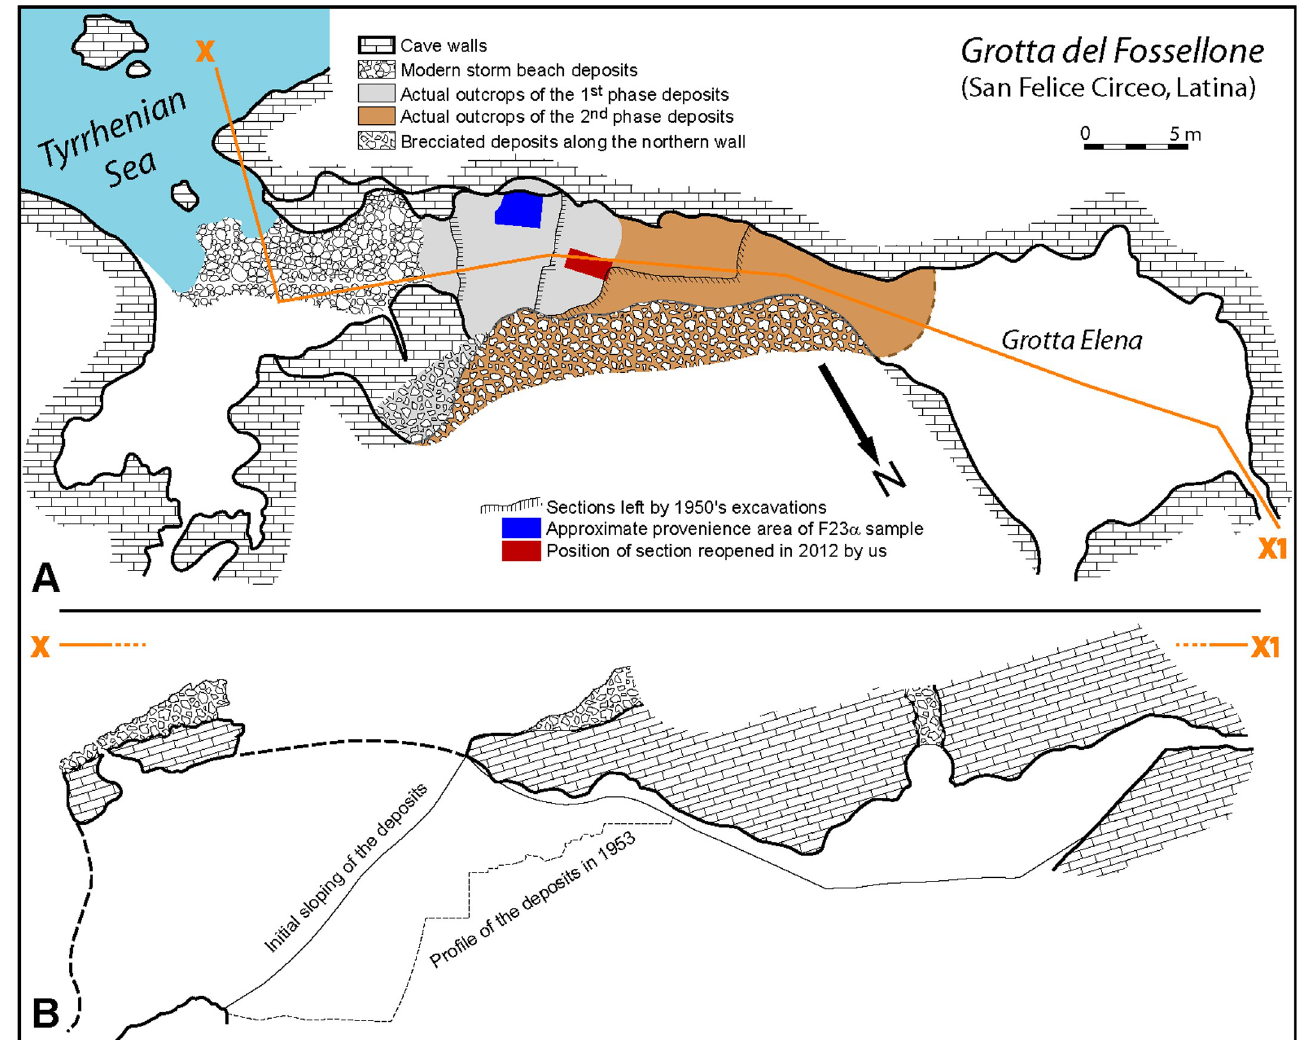
Fig 2. Plan and section of Grotta del Fossellone. ( A) Plan of the cave with location of the 2012 fieldwork, intact remnants of Pleistocene deposits and approximate provenience of F23 α sample from the 1947–1953 excavation. Modified from [50]. (B) Schematic longitudinal section of the cave showing the large opening in the roof, modified from [49]. Courtesy of the Istituto Italiano di Paleontologia Umana.